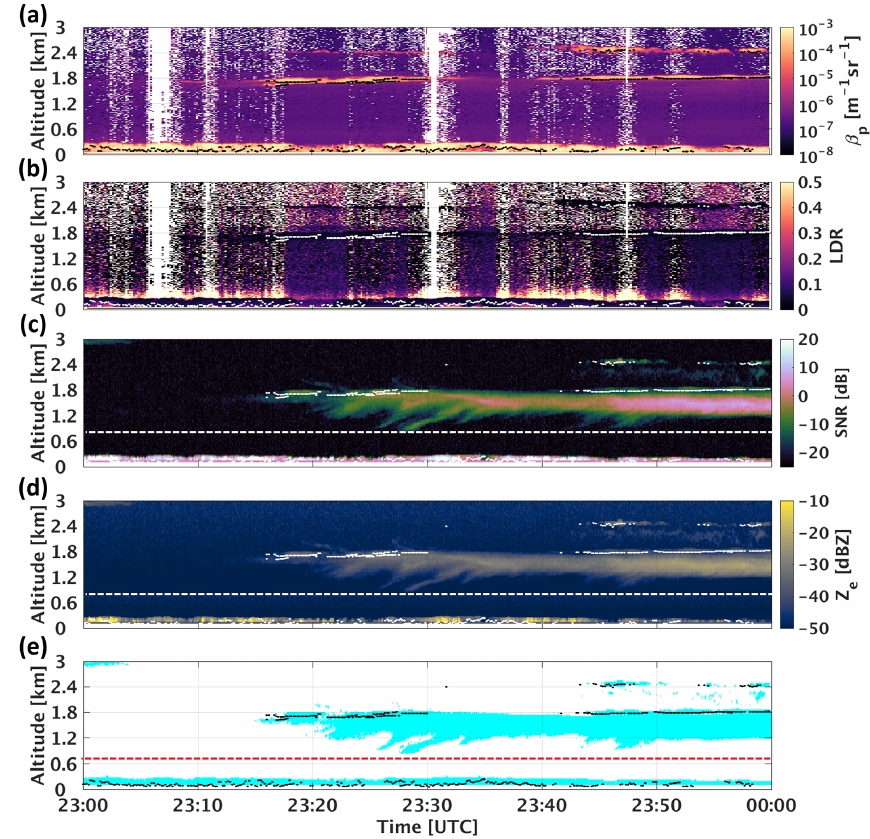
Figure C2. The same as in Fig. C1 but for a multi-layer event on 10 November 2015. See Appendix C for